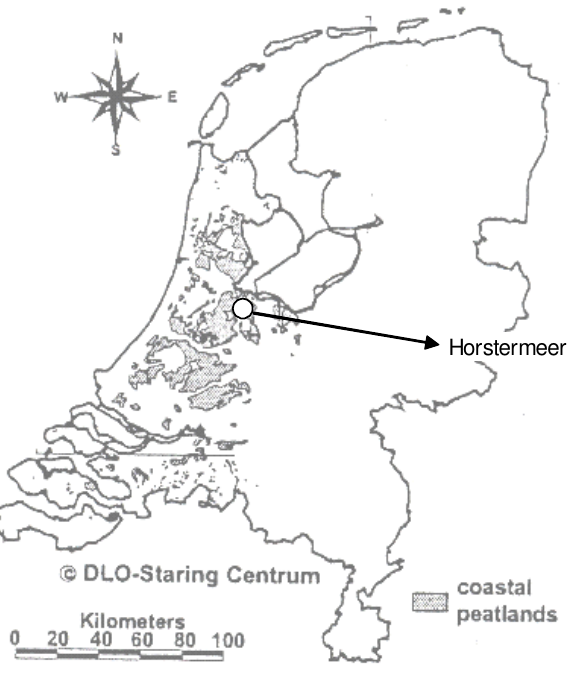
Fig. 1. Current distribution of peat soils in the western part of the Netherlands (SC-DLO 1992) and location of Horstermeer research